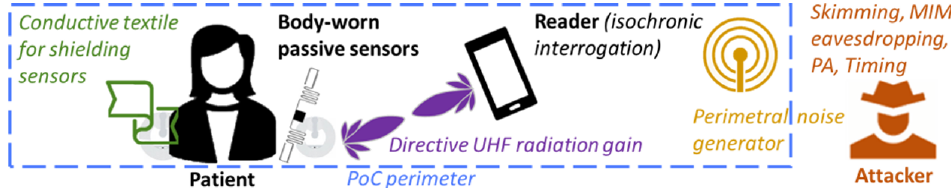
Figure 6. Sketch representing a secured tag-reader link in a domestic